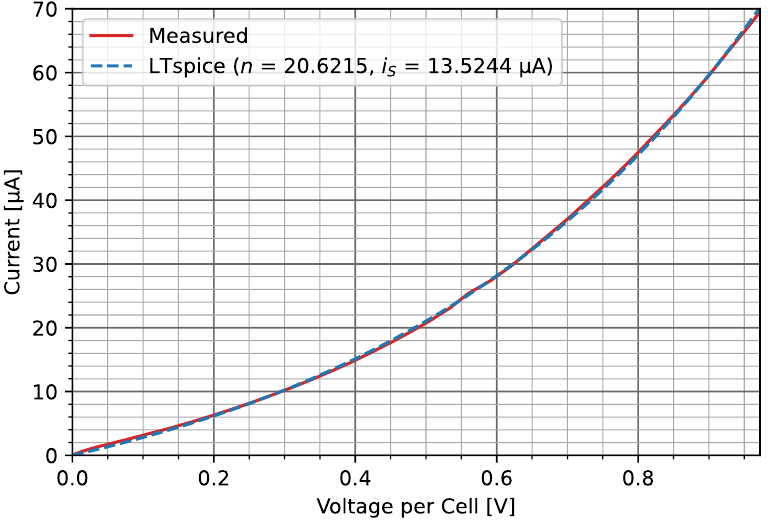
Figure 33. Small PV module measured and simulated current–voltage relationship for negative DC